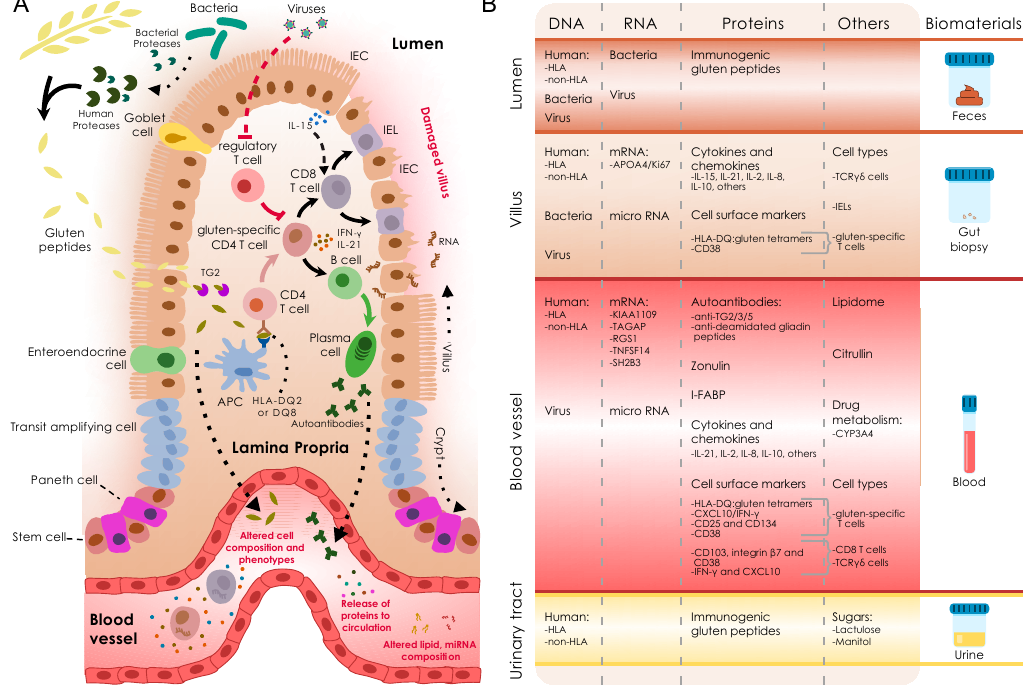
Figure 1. ( A ) Schematic representation of the immunopathology of Celiac Disease (CeD). Dietary gluten is partially degraded by human and microbial proteases. These peptides pass the epithelial layer (IEC: Intestinal epithelial cell) by paracellular or transcellular transport. Upon entering, tissue transglutaminase 2 (TG2) deamidates the gluten peptides, which are then processed by antigen presenting cells (APCs) and presented to CD4 + T cells in the context of human leukocyte antigen (HLA)-DQ2 or HLA-DQ8. After a process of selection, gluten-specific CD4 + T cells propagate and orchestrate the immune response by producing specific cytokines such as interleukin (IL)-21 and interferon-gamma (IFN- γ ).CombinedwithIL-15,thesecytokinespromotethedevelopmentofBcellsintoantibody-producing plasma cells and the activation of intraepithelial lymphocytes (IELs), which acquire cytotoxic properties to attack intestinal epithelial cells, thereby causing villus atrophy. The immune response in CeD causes modifications observable in blood such as release of immune- or damage-related markers (highlighted in red). Figure adapted from Moerkens and Mooiweer et al., [35]. ( B ) CeD biomarkers currently under study categorized by different compartments (rows, left) and separated by biotype (columns). Biomarkers that can be analyzed in easily collected biomaterials rather than invasive biopsies are more desired for diagnostics (rows,